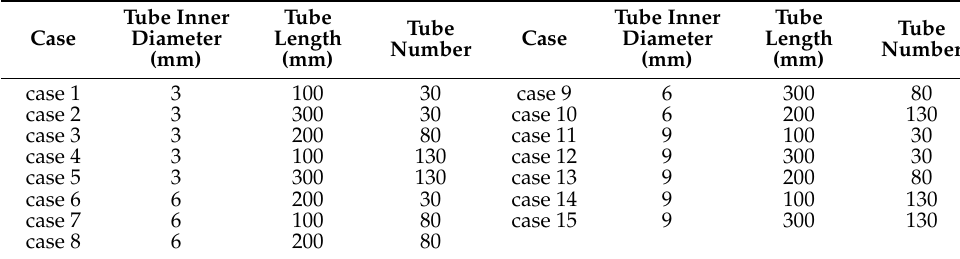
Table 4. HHX tube design set of central composite design